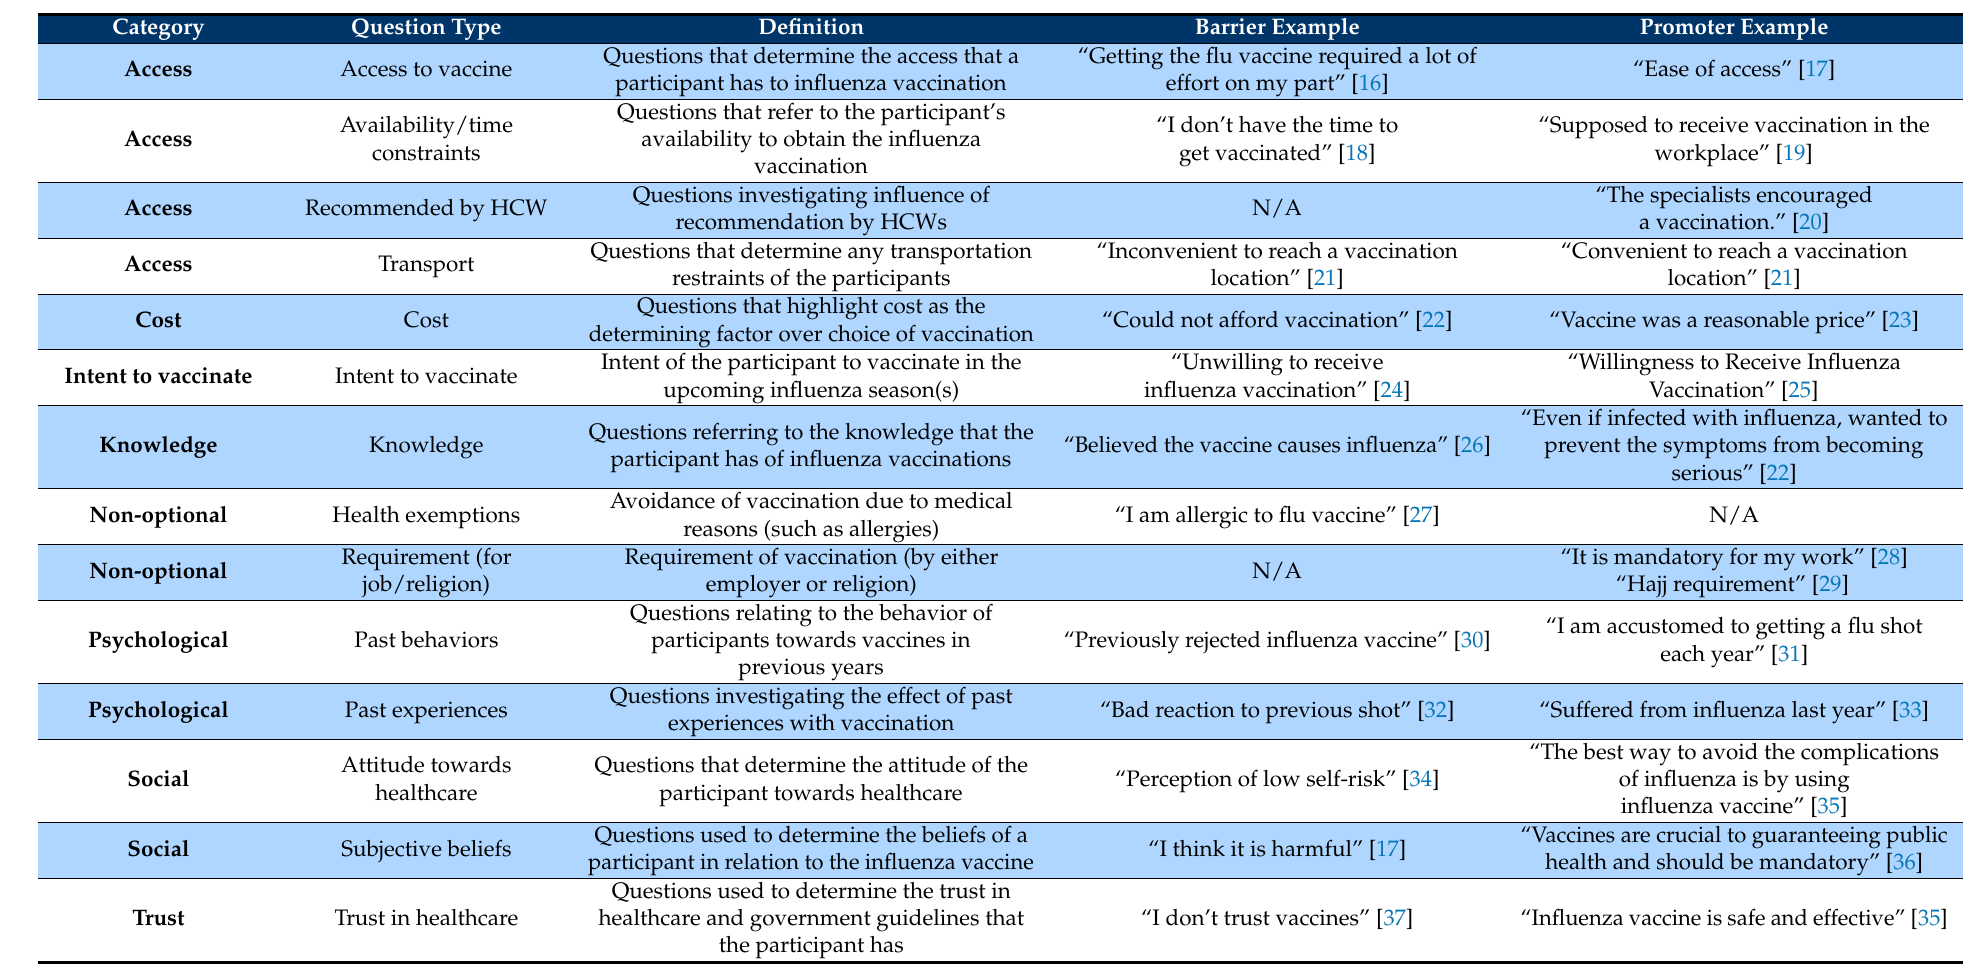
Table 2. Categorization of question